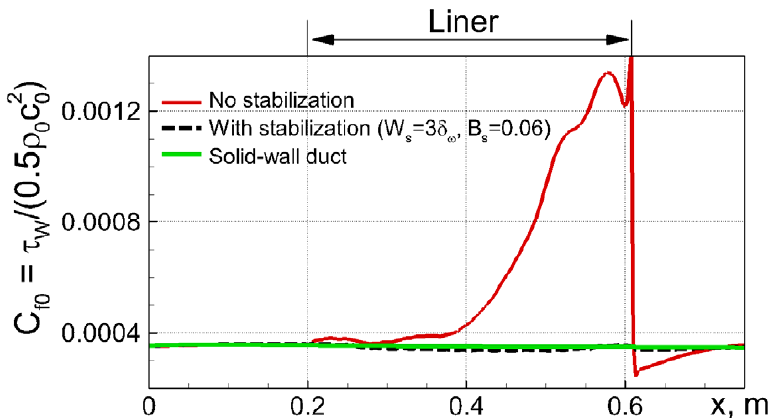
Figure 20. E ff ect of stabilization (10) with optimal parameters on skin-friction at lined wall of GIT.